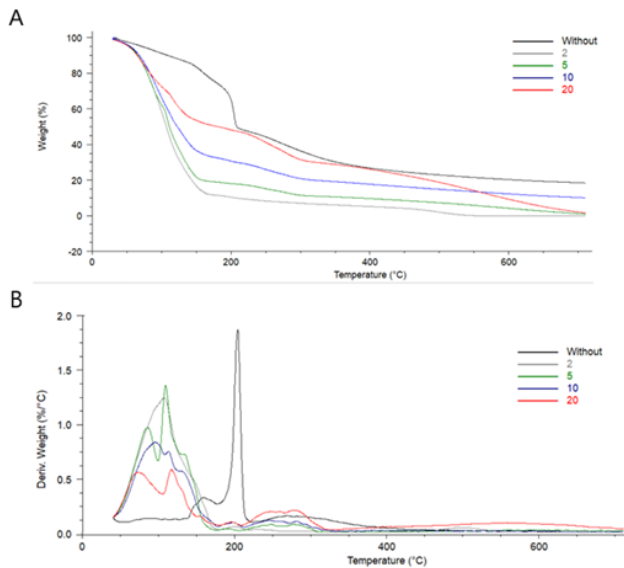
Figure 3. The TGA ( A ) and DTA ( B ) curves of chitosan-based hydrogels cross-linked by glyoxal without TA and after immersion in 2, 5, 10, and 20% tannic acid solution.